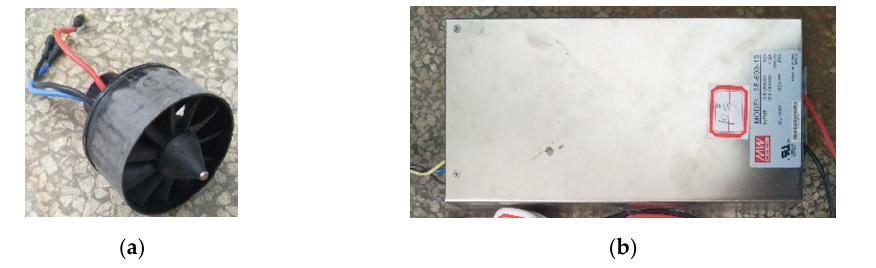
Figure 7. ( a ) Ducted fan; ( b ) switching power supply.